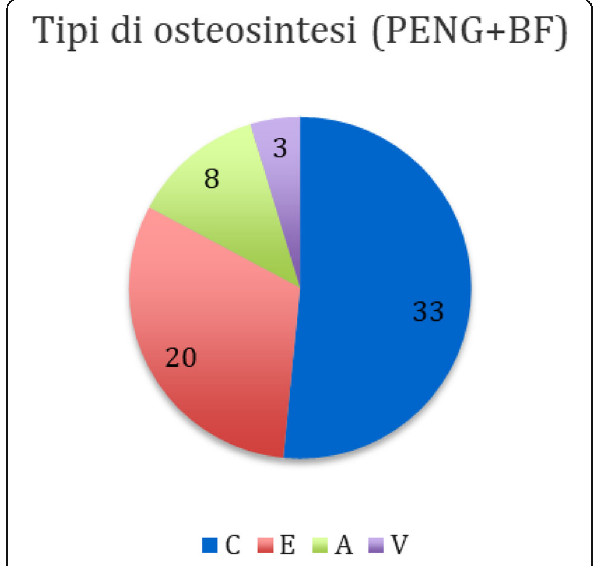
Fig. 2 (abstract A50). Femur fracture surgery (PENG+